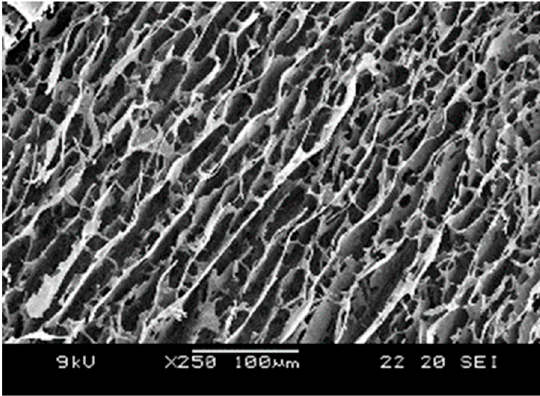
Figure 3. SEM image of P–Lys–Ala–PLX hydrogels.